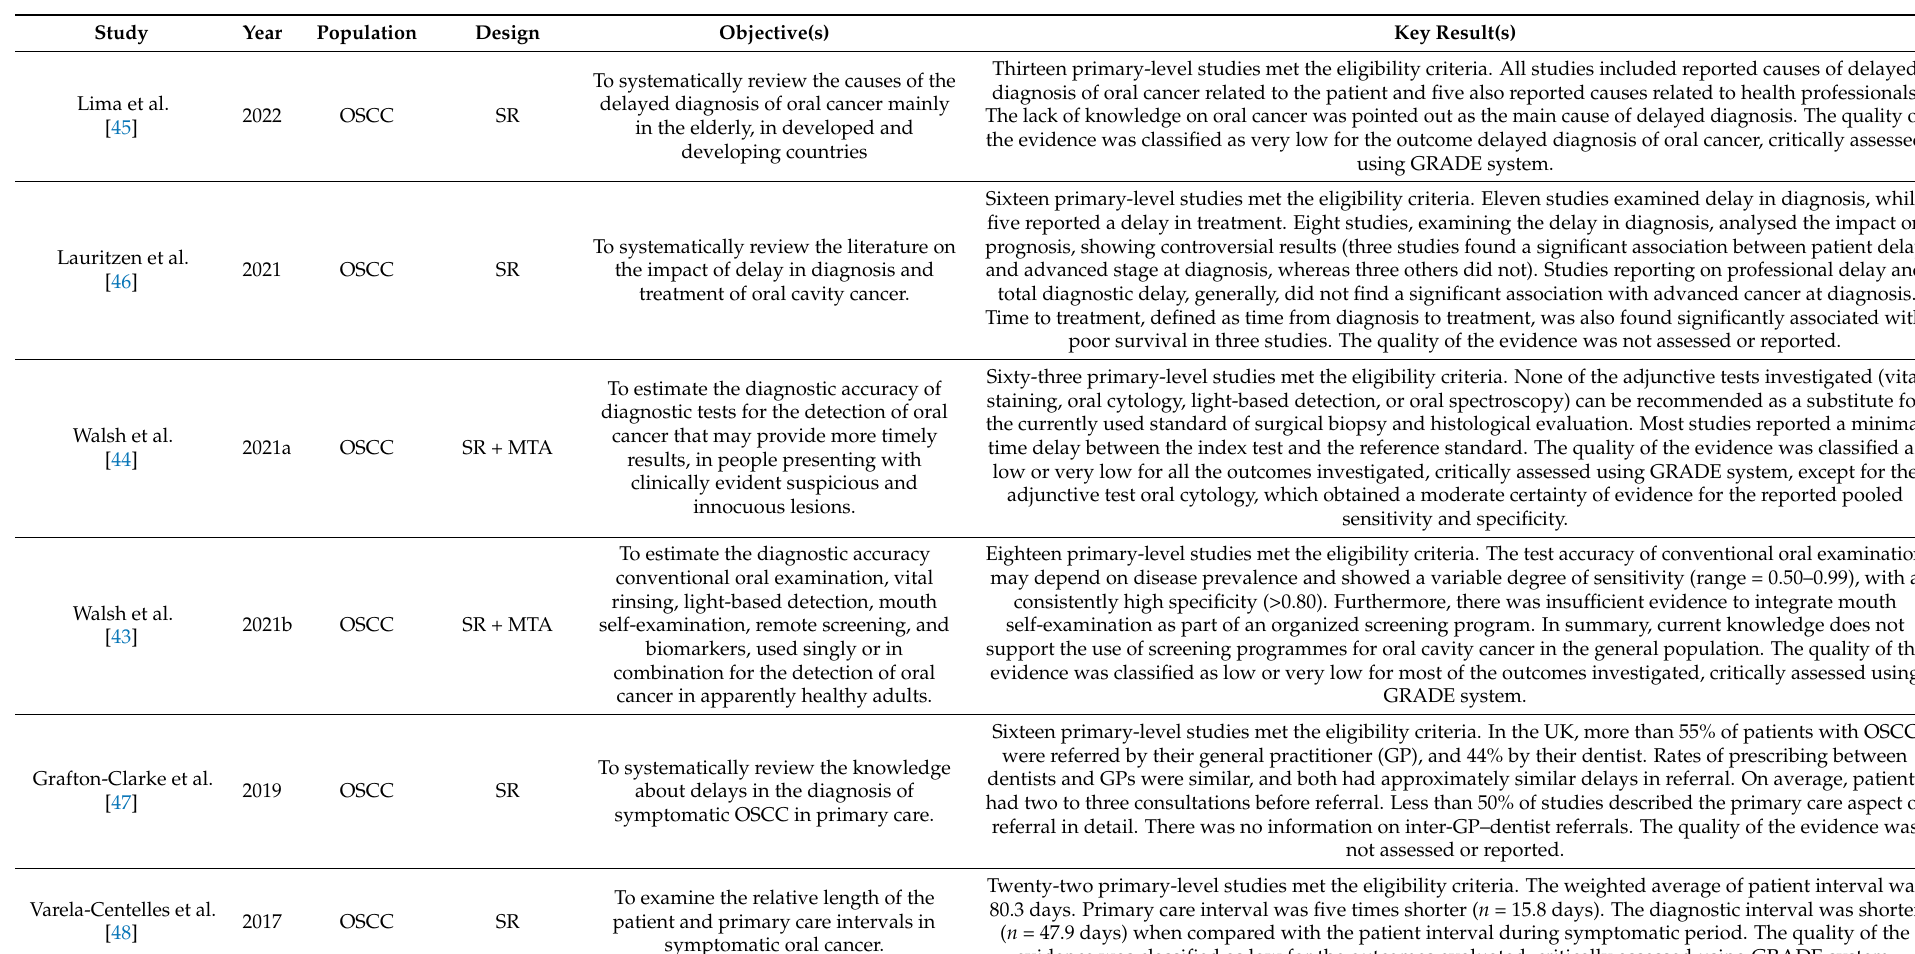
Table 2. Systematic reviews and meta-analyses included in this scoping review, focused on the implications of diagnostic delay in oral cancer ( n =